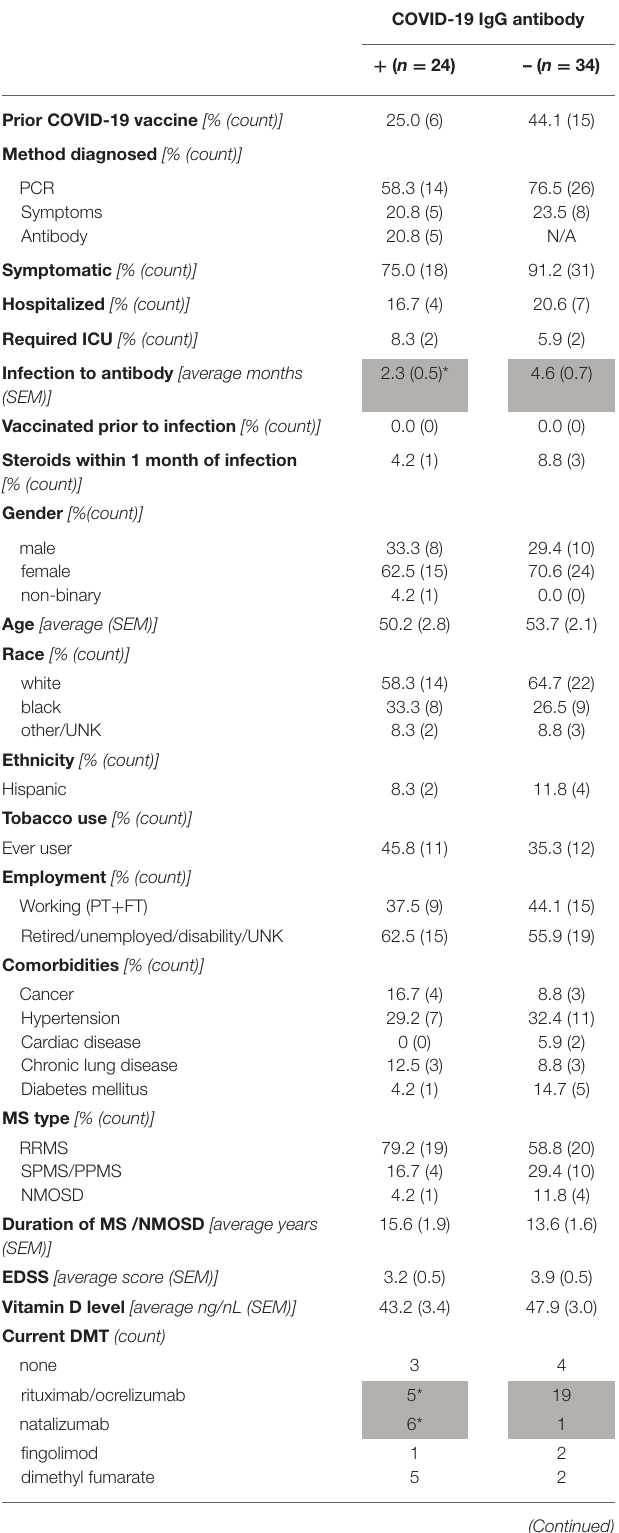
TABLE 1 | Demographics and clinical characteristics of COVID-19 IgG seropositive and seronegative patients with CNS demyelinating disorders and prior COVID-19